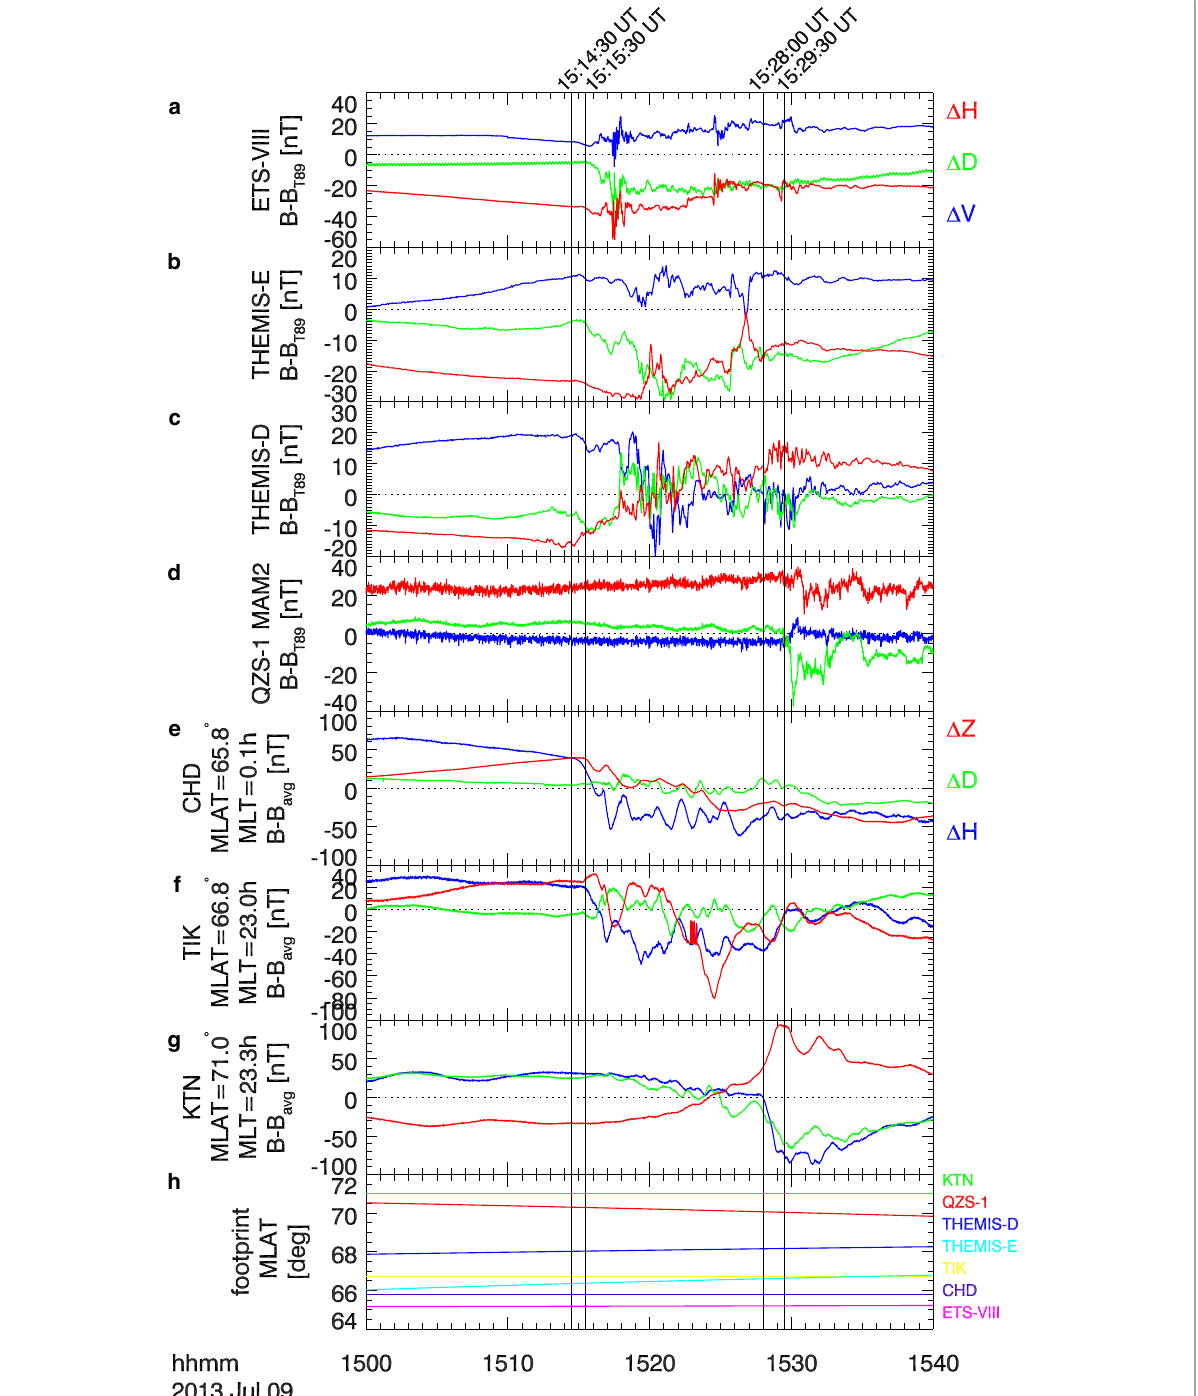
Fig. 2 Magnetic field data from a ETS-VIII, b THEMIS-E, c THEMIS-D, d QZS-1, e CHD, f TIK, and g KTN. The satellite magnetic field data are subtracted by the Tsyganenko 89 model field at K p = 0 . The ground magnetic field data are subtracted by values averaged by their values in the plotted interval. The MLTs are AACGM MLTs at 15:15 UT. (h) AACGM magnetic latitude at 100 km in altitude of ionospheric footprints of satellites and ground